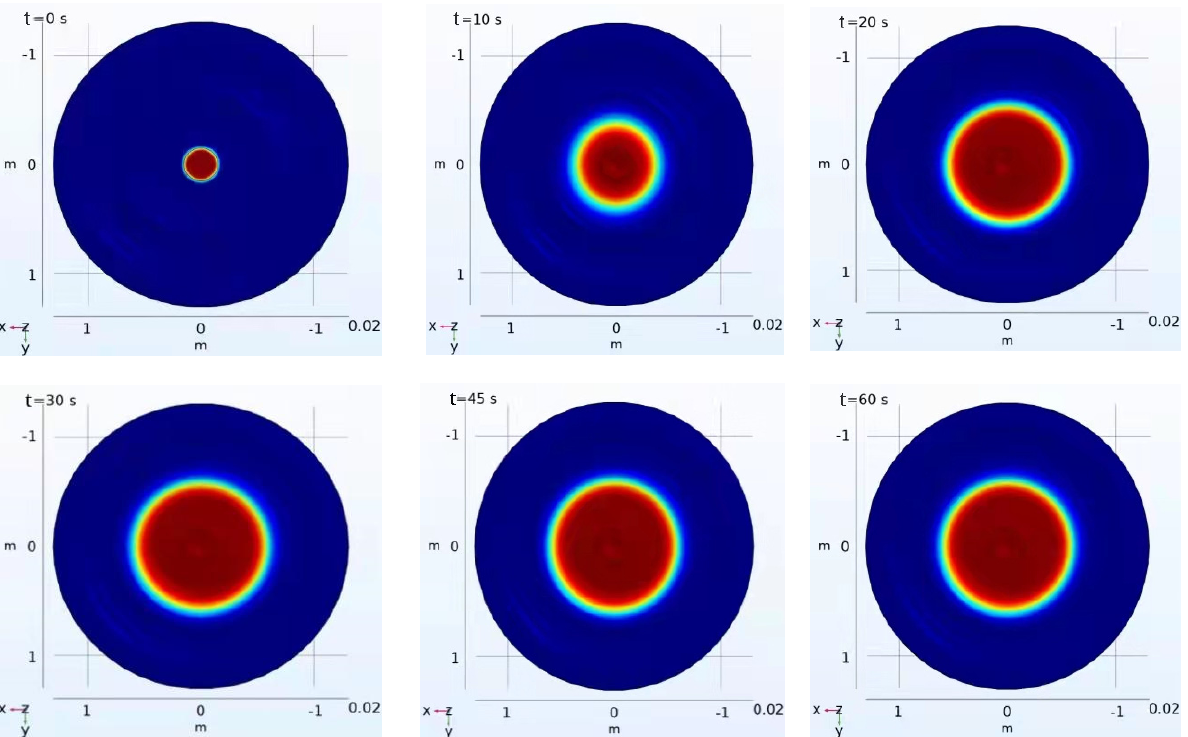
Figure 7. Simulation results of slurry volume fraction varying with time at different times.